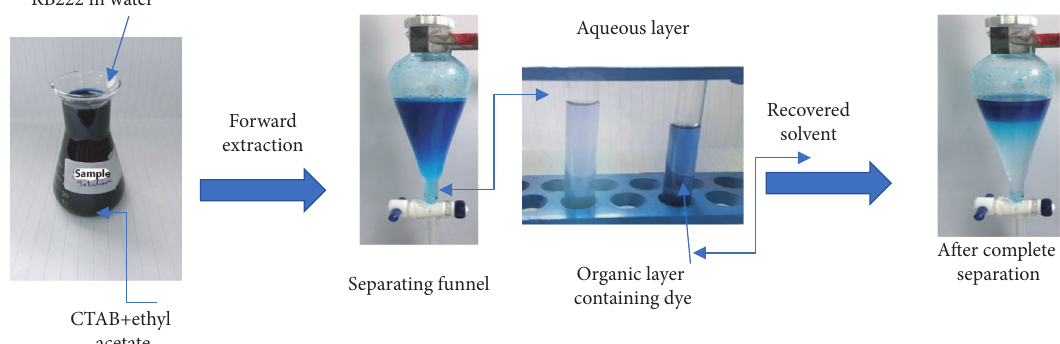
Figure 4: The experimental method for separation of RB222 dye from aqueous media and the extraction of